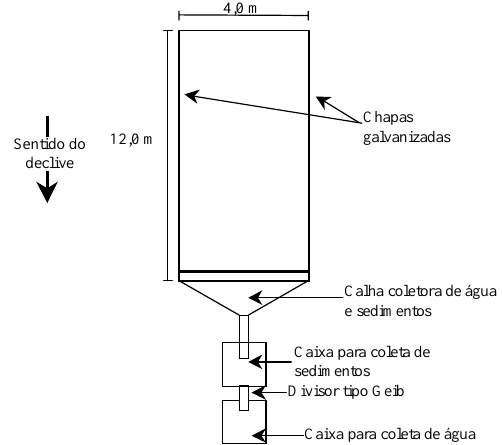
Figura 1. Desenho esquemático da parcela de coleta de sedimentos e de